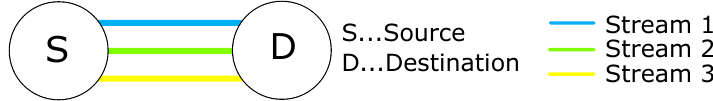
Figure 12. Simulation topology for multiple streams on shared